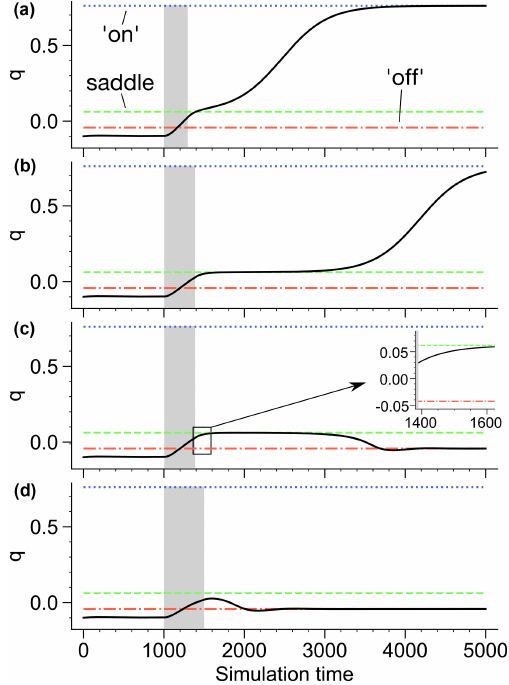
Figure 6. Time series of q = T − S in the Stommel model when ramping the parameter from η 1 = 2 . 65 to η 1 = 3 . 0 at different rates. The realizations are initialized at T,S = (2 . 4 , 2 . 5), which is close to the off fixed point at η 1 = 2 . 65. The duration of the ramping is indicated by the gray shading. The realizations in (a) and (b) with ramping durations of 300 and 388.5 years, respectively, tip from the off to the on attractor. The realizations in (c) and (d) with ramping durations of 389 and 500 years, respectively, track the moving off attractor. The on, off and saddle fixed points at η 1 = 3 . 0 are shown as horizontal